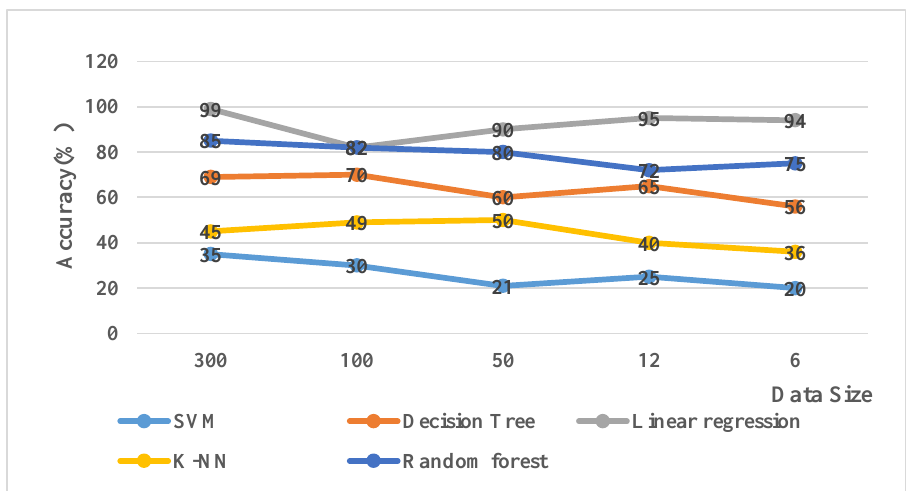
Figure 12. Analysis of noisy and typical frequency spectrum in the time domain in various pressure bar (regression analysis). Table 5. Vibration analysis result .